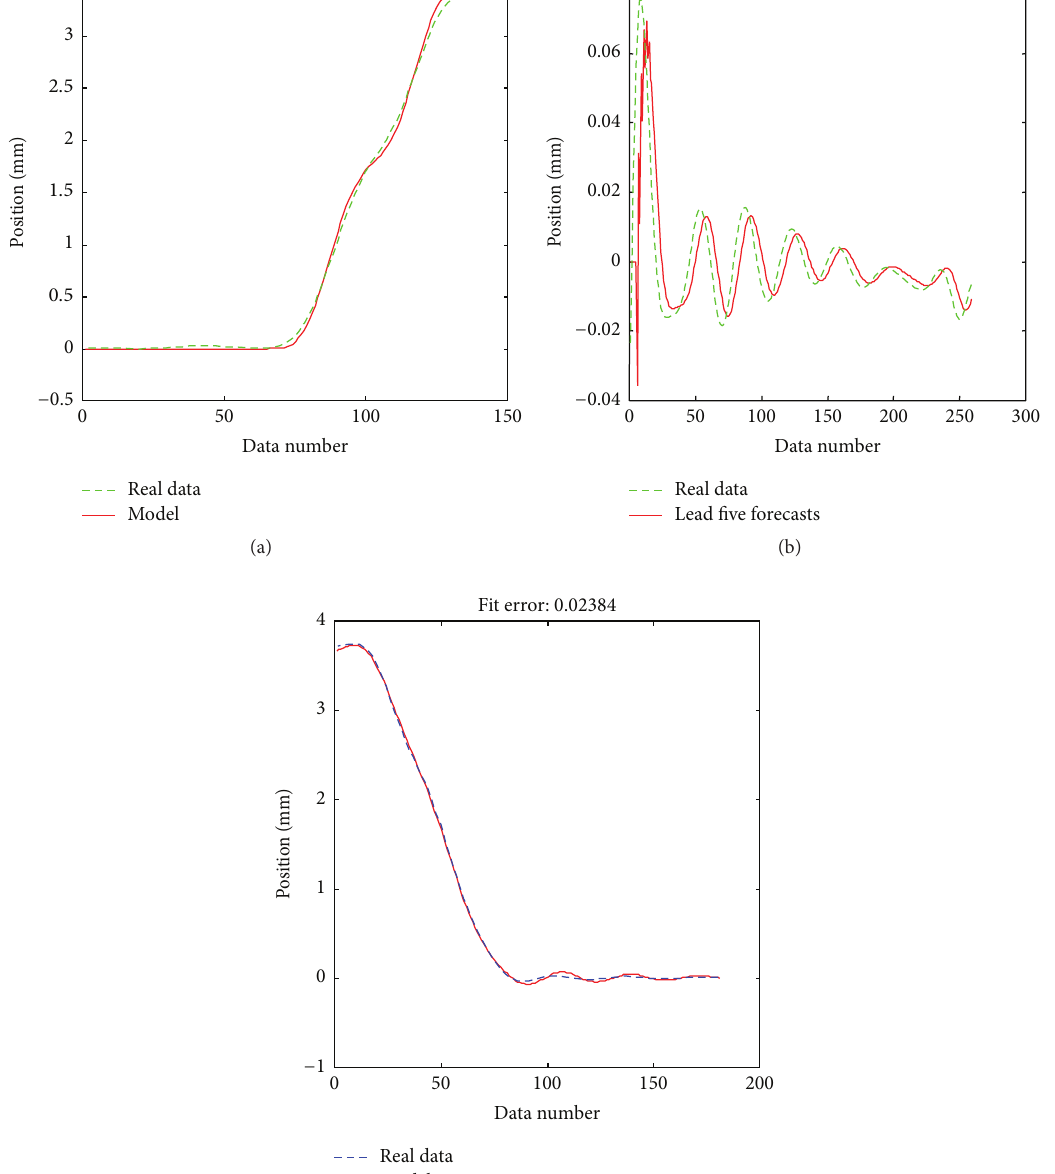
speed is presented. Results of frequency analysis indicate greater natural frequency and system stiffness caused by nonlinear dynamics for higher operation speed. According